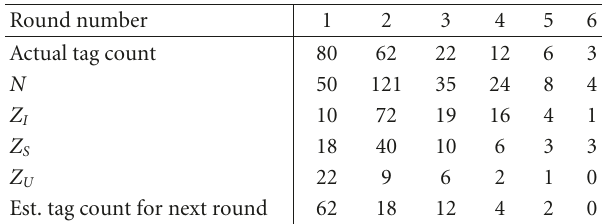
Table 1: Tag count estimation in an identification process of ASAP. Round